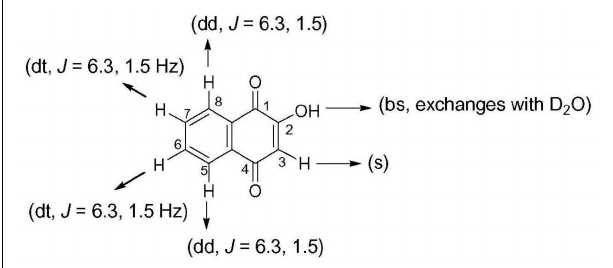
FIGURE 1 | Chemical structure of lawsone demonstrating antimicrobial and plasmid curing activity.